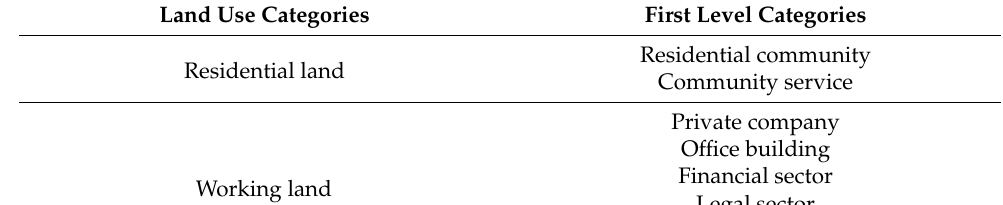
Table 1. The POIs categories to identify the land use categories. Land Use